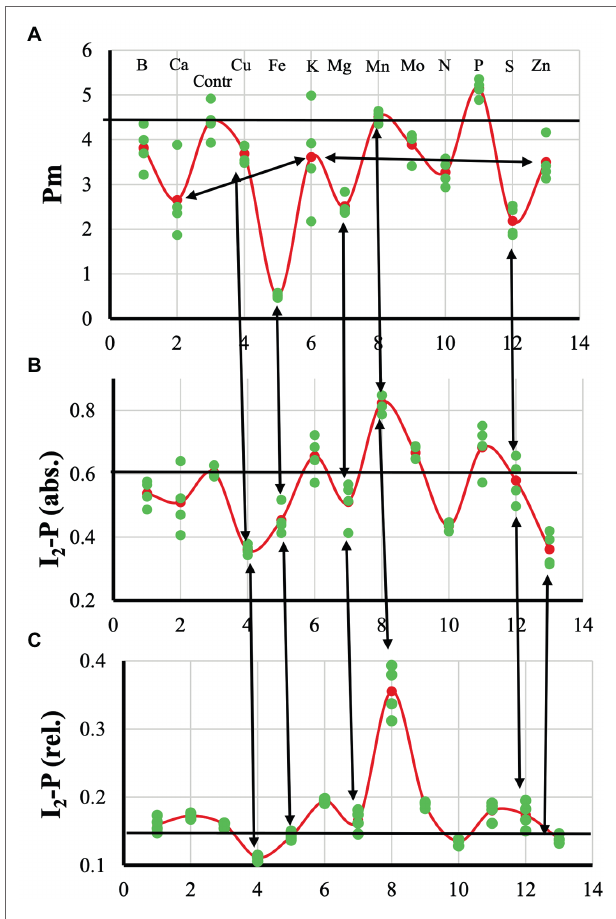
FIGURE 1 | Effect of the 12 mineral deficiencies applied to hydroponically grown sunflower plants on the Pm (A) , absolute (B) , and relative I 2 -P (C) amplitudes,